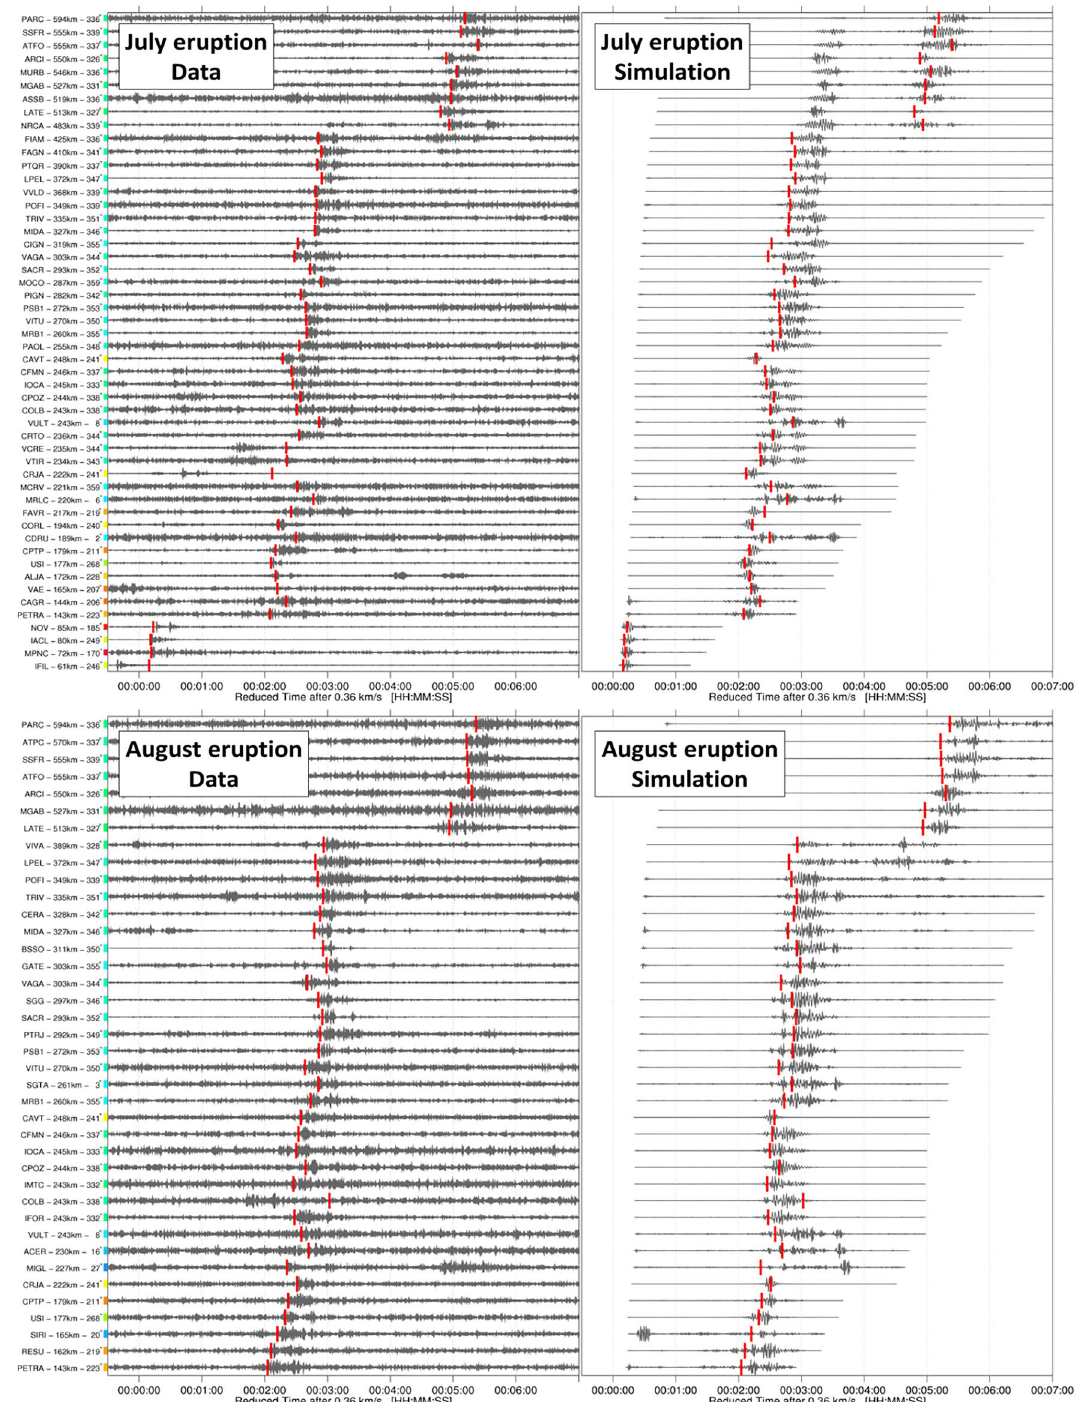
Figure 4. Comparison between the recorded (left panels) and the modeled (right panels) waveforms at seismic stations for July (top panels) and August (bottom panels) eruptions. Only stations with clear signals (SNR > 10 dB) are displayed (50 and 38 stations for the July and August eruptions, respectively). Station names, distances and azimuths are specified to the left. Waveforms are time-shifted using a constant celerity of 300 m/s. Vertical red bars are onset times of dominant arrival at each station used for the localization (Figs. 4 and 5), performed on the recorded waveforms band-pass filtered between 0.5 and 2 Hz. To ease the comparison between data and simulation, picks are reported on the modeled waveforms (right). A good agreement beween the predicted and observed arrival times, but also shapes and durations is